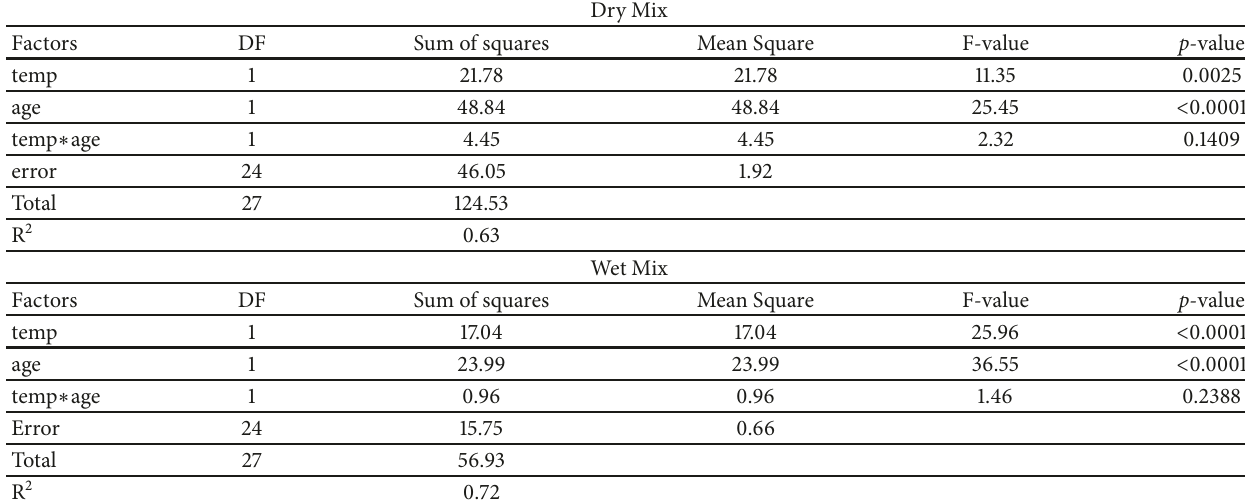
Table 4: ANOVA table for rut depth under wet conditions and dry